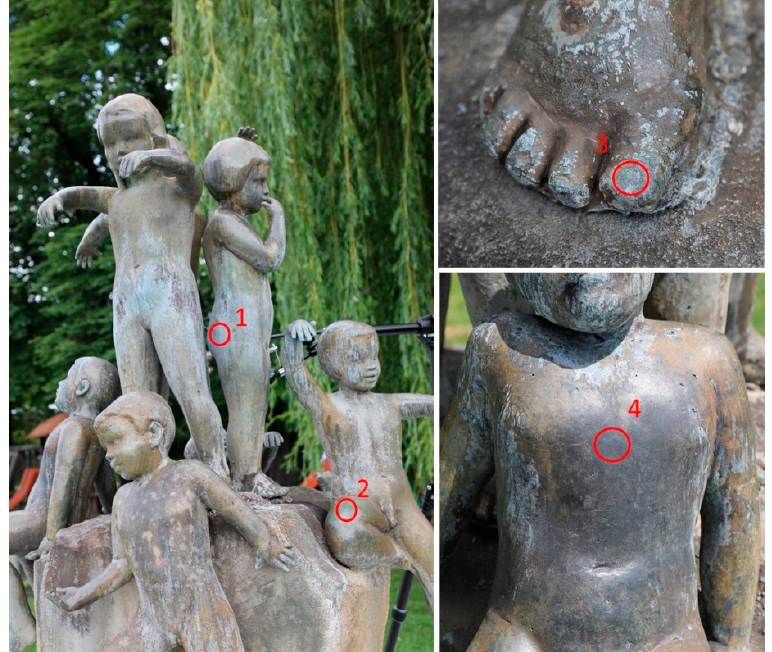
Figure 1. Sculpture Nedovršena igra with indicated test areas 1–4.